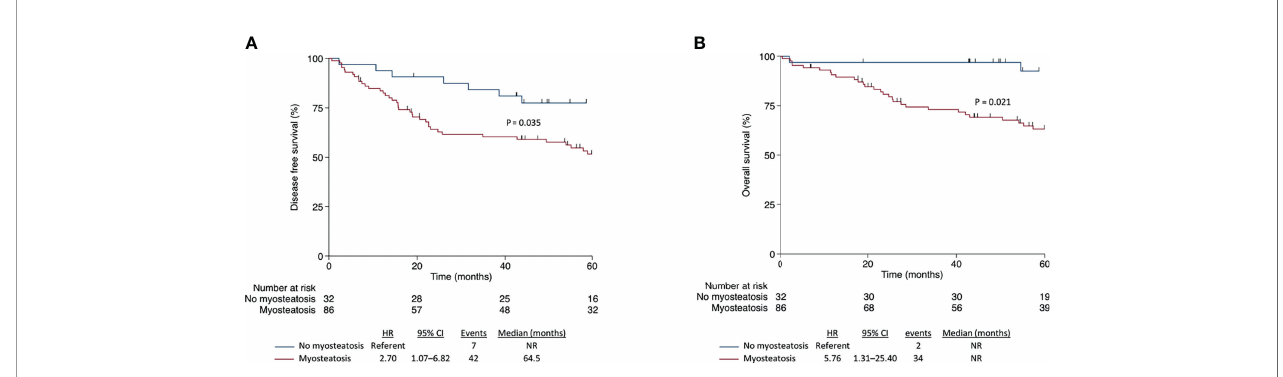
FIGURE 2 | Disease-free survival (A) and overall survival (B) according to myosteatosis in patients with